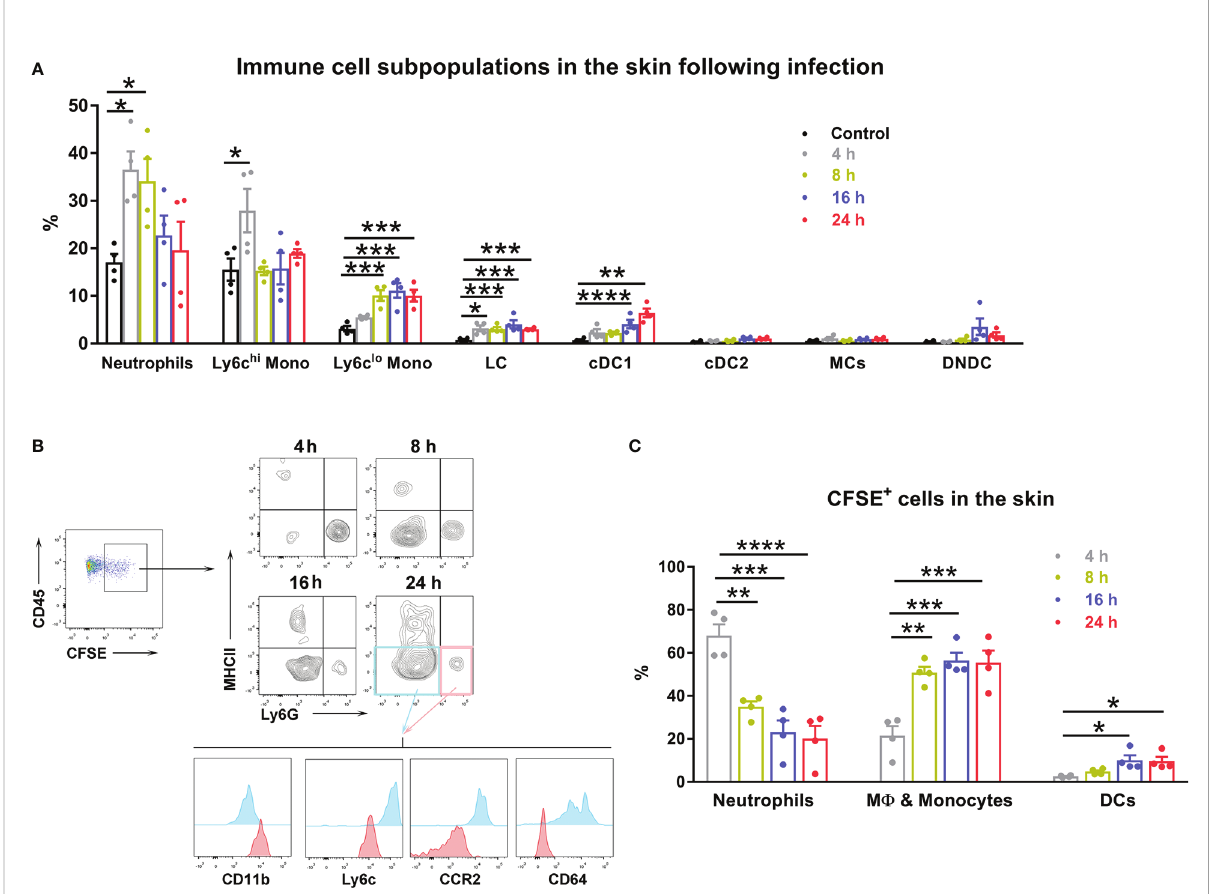
FIGURE 1 Innate immune cells displayed a dynamic pattern at the inoculation site of Ot infection. B6 mice (n=4/group) were intra-dermally (i.d.) infected with CFSE-labeled Ot (4×10 3 FFU) in the ears. Skin tissue was harvested at indicated time-points, digested by collagenase, and prepared for single cell suspension. Control mice were euthanized immediately after injection. (A) The dynamic pattern of innate immune cell subpopulations in fi ltrating the inoculation site is displayed. (B) CD45 + and CFSE + positive immune cells from infected mice were further characterized by immune cell types using surface markers. MHCII + cells were considered antigen presenting cells including cDC1 (MHCII hi CD24 hi CD64 - EpCAM - ), cDC2 (MHCII hi CD172a hi CD11b + CD64 - EpCAM - ), DN (double negative) DC (CD11b - MHCII hi CD24 - CD64 - EpCAM - ), and Langerhans cells (MHCII hi CD24 hi EpCAM + ). Monocyte-derived in fl ammatory cells (MC) were identi fi ed as MHCII + CD11b hi CD64 hi Ly6C - . MHCII - Ly6G + cells (pink quadrant), which were also CD11b hi Ly6C int CCR2 int CD64 - , were characterized as neutrophils. MHCII - Ly6G - cells (blue quadrant) were identi fi ed as macrophages and monocytes, as they were CD11b int Ly6C + CCR2 hi CD64 + . (C) The dynamic pattern of Ot infected-immune cells at the site of Ot inoculation 4 h post-infection is shown. Values are shown as mean ± SEM from single experiments and are representative of